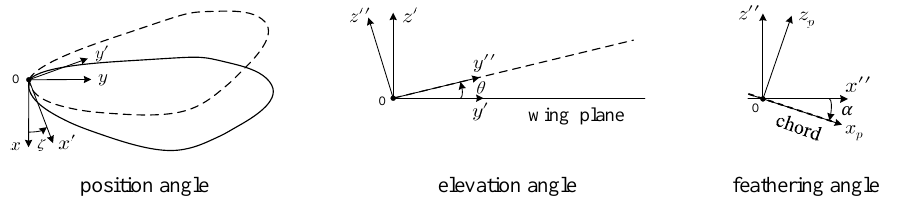
Figure 3. Wing model in a rotating reference